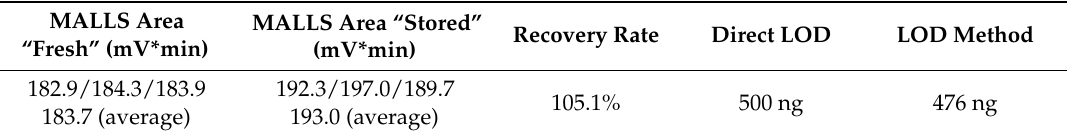
Table 2. Recovery experiment made with a 1000 ng/mL laponite dispersion (2000 µL injections, samples prepared in triplicate).